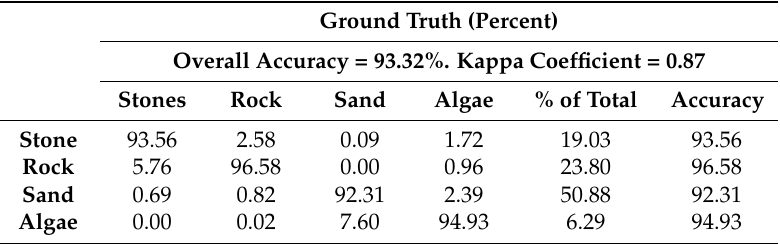
Table 5. Confusion Matrix using ground